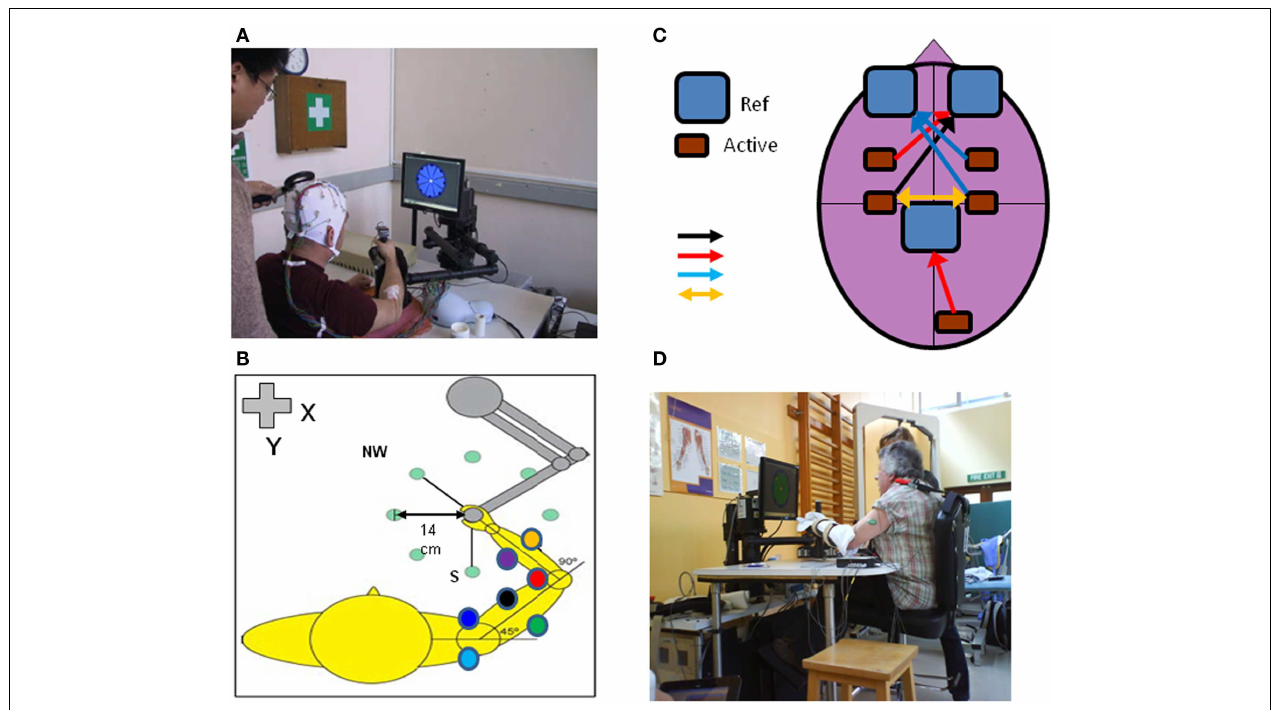
types of tDCS include: unilateral anodal motor cortex – black arrow, unilateral anodal premotor or visual cortex – red arrows, unilateral cathodal stimulation – blue arrows or directional stimulation – yellow arrow; Ref, reference electrode, Active, active electrode).The robotic device can be used to assist acute stroke patients in reaching motor practice in therapy or be programed to perturb motor performance to measure patient kinematic performance and muscle responses in different tasks such as position holding [ (D) ; see also Figure 4